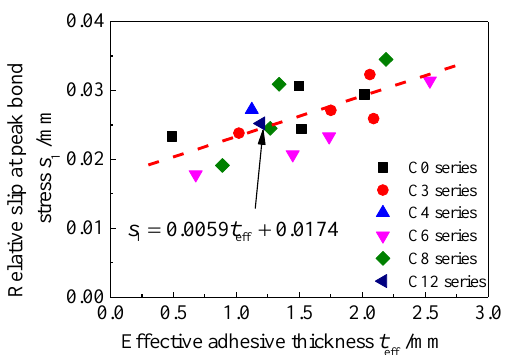
s with respect to effective 1